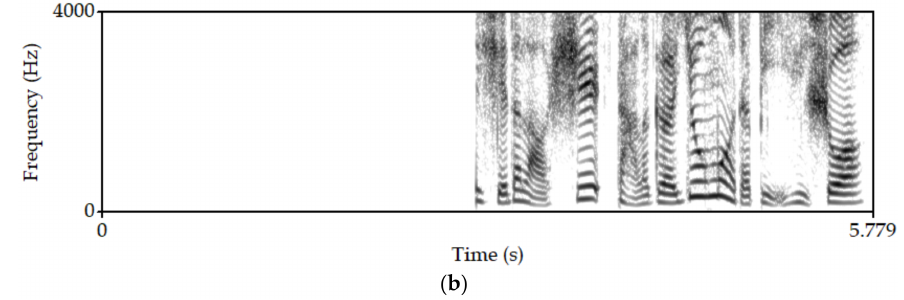
Figure 8. Damaged speech signal, the tampering percentage is 47.6% ( a ) Waveform ( b ) Spectrogram.